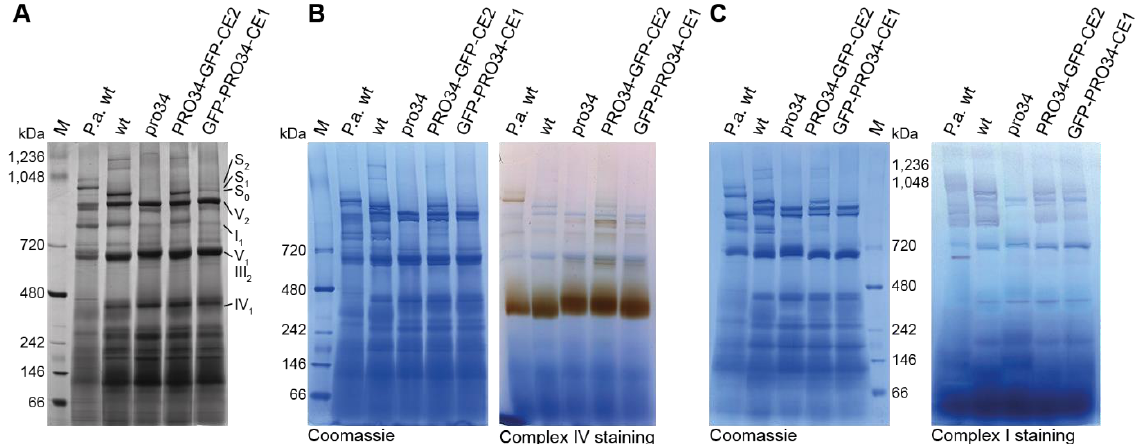
Figure 4. BN-PAGE and “in-gel” activity assay of mitochondrial respiratory chain complexes. For each lane, 100 ( A,B ) or 200 µg ( C ) mitochondrial protein extracts were solubilized using a digi- tonin/protein ratio of 3:1 ( w / w ). ( A ) The components of the respiratory chain were visualized by Coomassie blue staining and assigned according to [44]. The Podospora anserina wild-type strain (P.a. wt) was used as a control strain for mitochondrial complex identification. Complex V monomer (V 1 ) and complex III dimer (III 2 ) migrate at the same size. Complex IV staining in ( B ) and complex I staining in ( C ) were performed according to [45]. I 1 , complex I monomer; III 2 , complex III dimer; IV 1 , complex IV monomer; V 1 , complex V monomer; V 2 , complex V dimer; S 0 , supercomplex I 1 III 2 IV 0 ; S 1